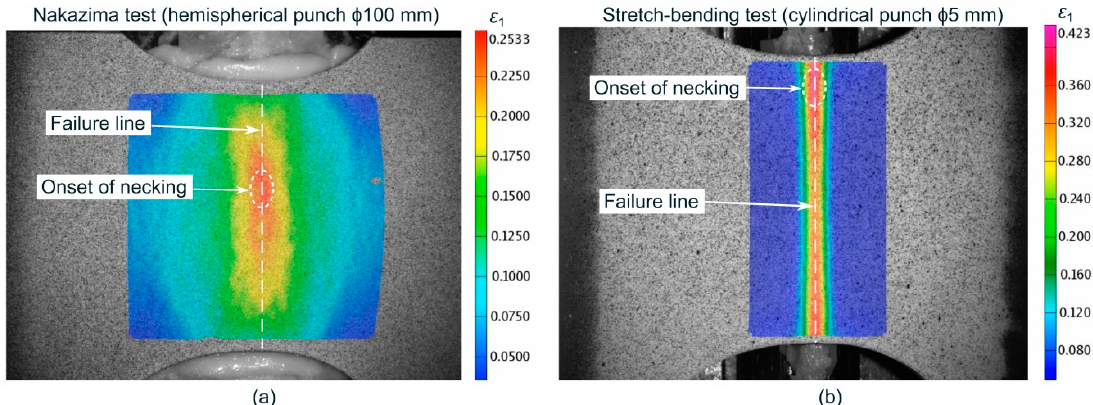
Figure 4. Experimental major strain contours at the outer surface in a stage near the onset of necking for a ( a ) φ 100 mm Nakazima punch and ( b ) φ 5 mm cylindrical punch.